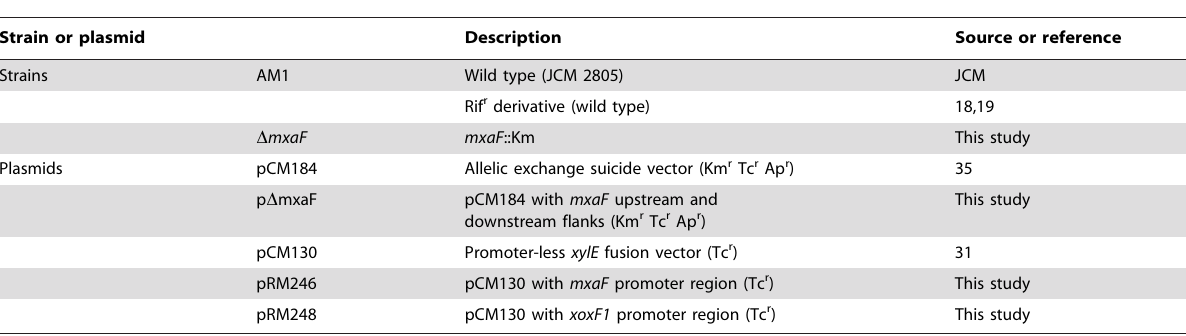
Table 2. Strains and plasmids used in this study.